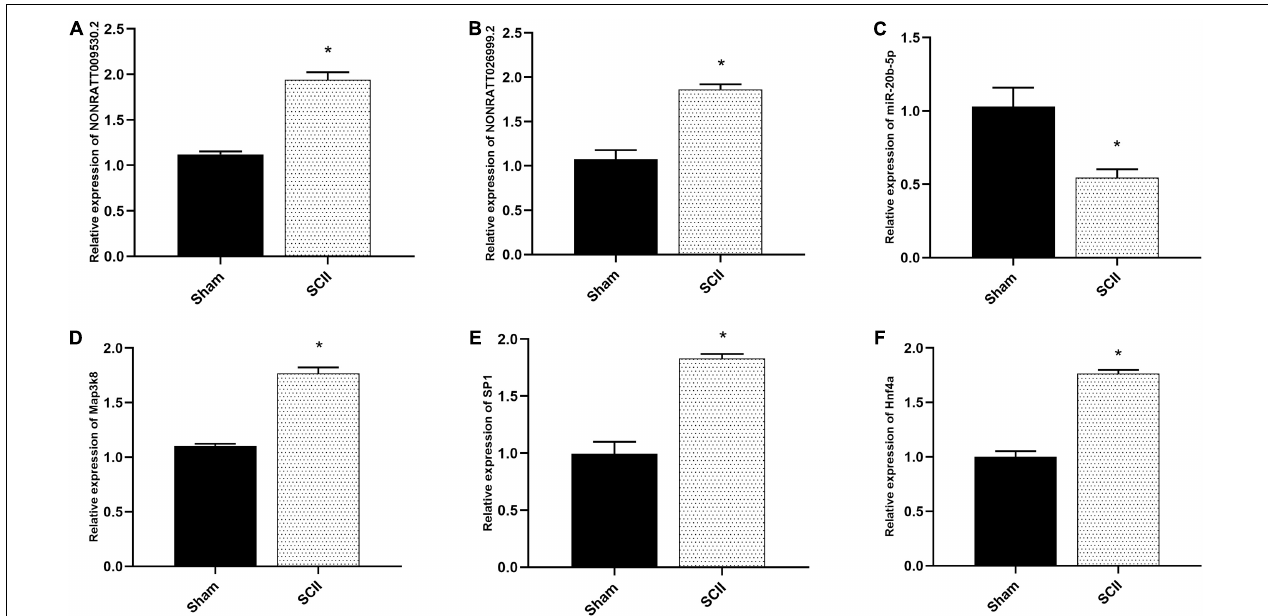
FIGURE 7 | The mRNA expression of hub genes in SCII of rats. (A,B) The key lncRNAs expression of NONRATT009530.2 and NONRATT026999.2 in spinal cord of rats were measured by qRT-PCR post SCII, and SCII induced upregulation of NONRATT009530.2 and NONRATT026999.2 ( n = 3). (C) The expression level of miR-20b-5p in spinal cord of rats in SCII ( n = 3). (D) Quantification of the Map3k8 expression by qRT-PCR ( n = 3). (E,F) Expression levels of SP1 and Hnf4a in a rat model of SCII ( n = 3). Data are expressed as the mean ± standard deviation. * p < 0.05 vs. the sham group.